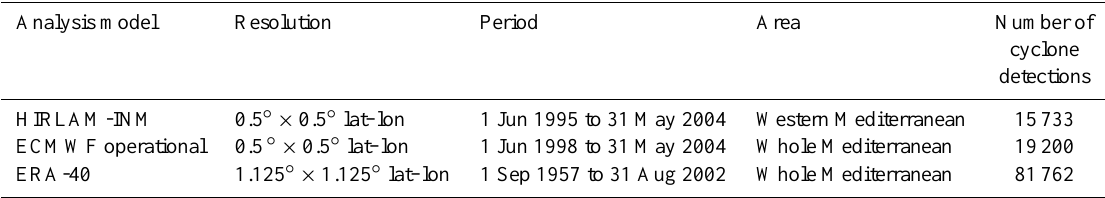
Table 2. MEDEX databases of cyclones. Four analyses per day. Analysis model